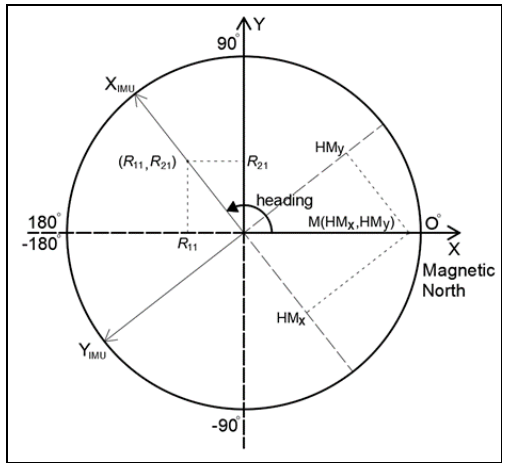
Figure 2. Connection of the sensor coordinate system with the ground reference system in the horizontal plane.